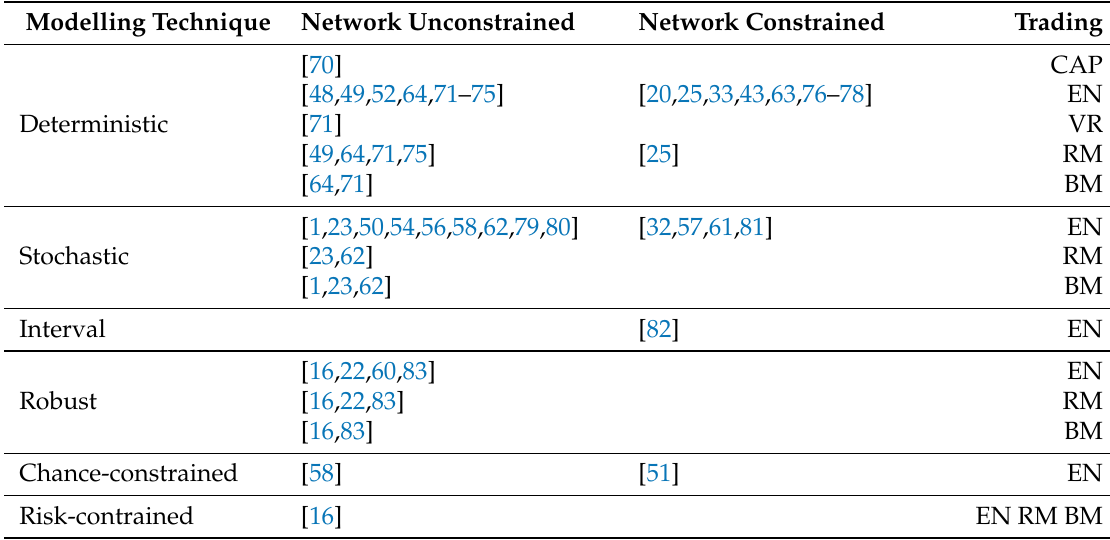
Table 1. Literature survey on the competitive ESS operating at the transmission level. (Abbreviations: CAP, capacity; EN, energy only; VR, voltage regulation; RM, reserve market; BM, balancing market). Modelling